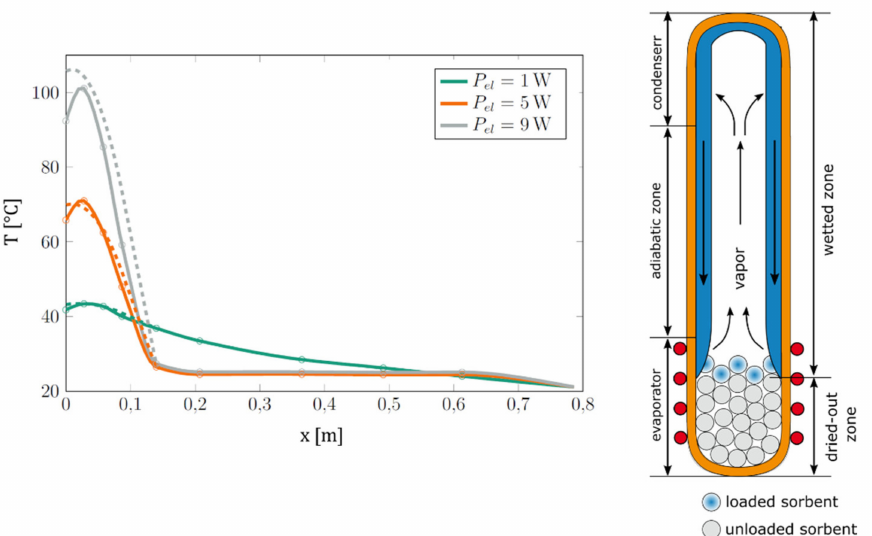
Figure 7. Left: Measured temperature distribution of Siphon-1 (full lines) compared to the modeled temperature distribution of the empty evacuated tube body of Siphon-1 (dashed lines) for different heat powers. Model data were obtained as described in Appendix A.1. Right: Illustration of heater dryout in Siphon-1 in the on-state, explaining the observed high temperature gradient in the heater area and the high thermal resistance in the